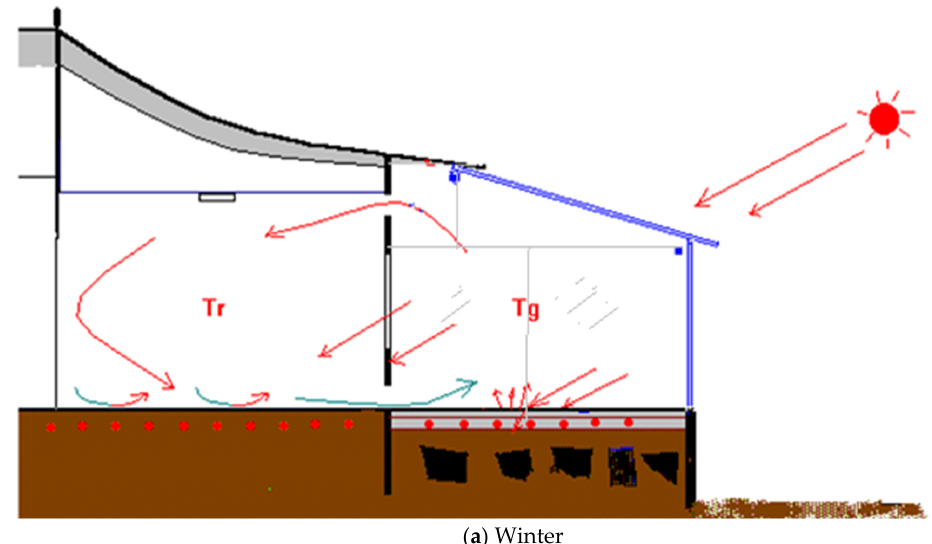
Figure 1. Principles of radiant cooling without any energy input.